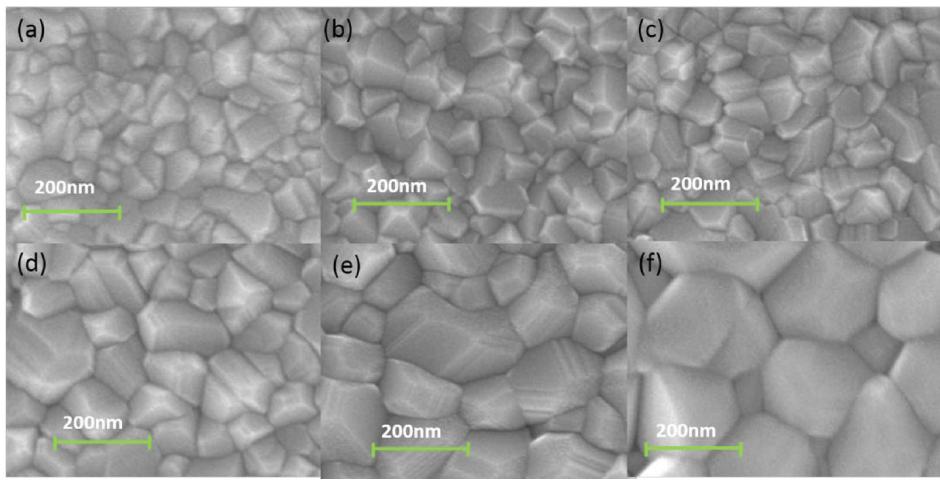
Fig. 3 FE-SEM images of MCNO thin films: surface morphology of the thin films annealed at (a) 650 ℃ , (b) 700 ℃ , (c) 750 ℃ , (d) 800 ℃ , (e) 850 ℃ , and (f) 900 ℃ .